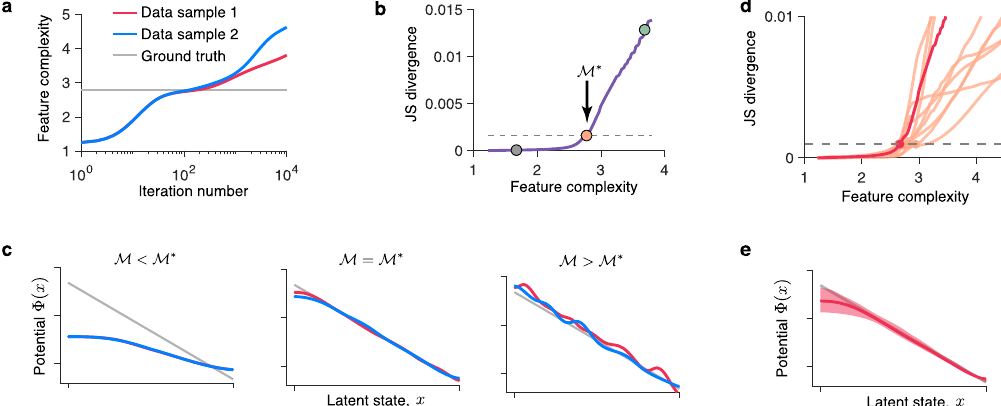
Fig. 5 Model selection and uncertainty quanti fi cation. a Feature complexity M increases over GD iterations at a rate that varies across data samples. The ground-truth feature complexity (gray line) is achieved on different iteration for different data samples. b JS divergence between the models discovered from data samples 1 and 2 for each level of the feature complexity. The optimal value M (cid:4) is de fi ned as a maximum feature complexity for which JS divergence does not exceed a fi xed threshold (dashed line). The dots correspond to the potential in c . c A pair of fi tted potentials at M < M (cid:4) (left, gray dot in b ), M ¼ M (cid:4) (middle, orange dot in b ), and M > M (cid:4) (right, teal dot in b ) for data samples 1 and 2 (colors correspond to data in a ). In all panels the ground-truth model is shown in gray. d JS divergences between models of the same complexity discovered from two data halves for each of 10 bootstrap samples (red line - same data as in b ). The same threshold is used to select a pair of optimal models for each bootstrap sample. e Fitted potential (red) is the average of two potentials at optimal M (cid:4) produced by the model selection (middle panel in c ). The con fi dence bounds (shaded area) are obtained as a pointwise 5% and 95% percentile across twenty potentials produced by the model selection on 10 bootstrap samples in d . The ground-truth model is shown in